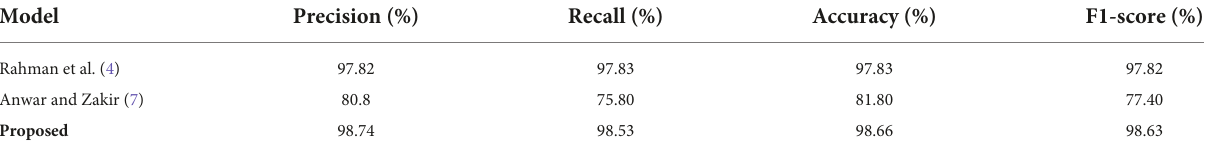
TABLE 6 Performance analysis of our approach with other latest